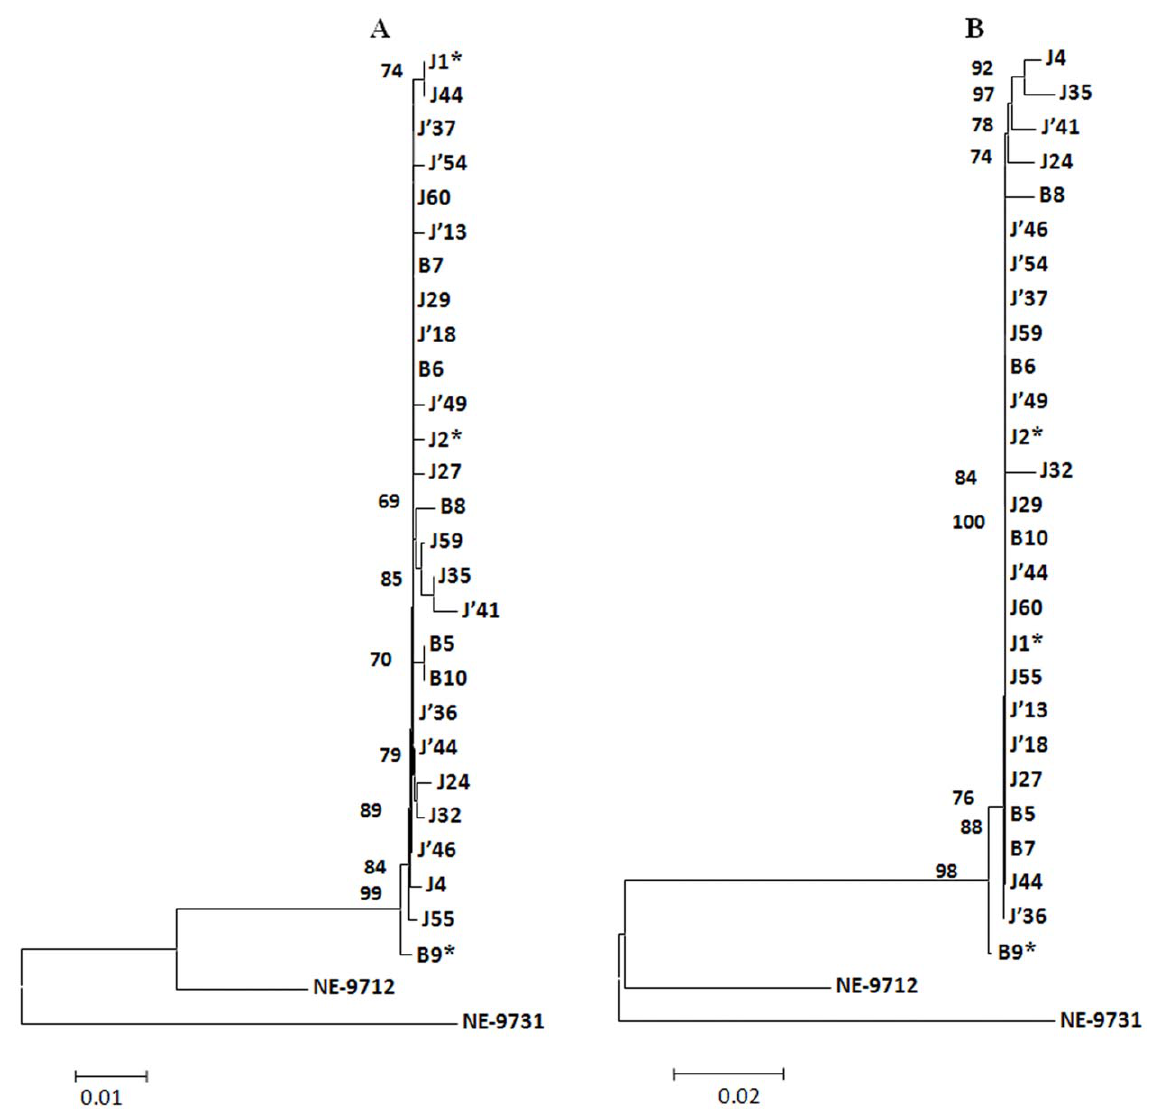
Figure 4. Phylogenetic trees for segment 12 and VP12 of LNV isolates from Xinjiang province. A: Phylogenetic tree based on the nucleotide sequences. B: Phylogentic tree based on the amino acid sequences. Bootstrap values for 500 replications are indicated at each node. The trees were constructed using the Neighbor joining method and the Kimura 2 parameters method (nucleotides) and Poisson’s correction method (amino acids). Similar trees were obtained with the P-distance algorithm. The bar represents the number of substitutions per site. Isolate designations are those reported in table 2. NE-9712 (LNV-NE9712) and NE-9731 (LNV-NE9731) are prototype strains of LNV serotypes 1 and 2, respectively. The letter B in isolates designation refers to Boshikeranmu while J refers to Jiashi